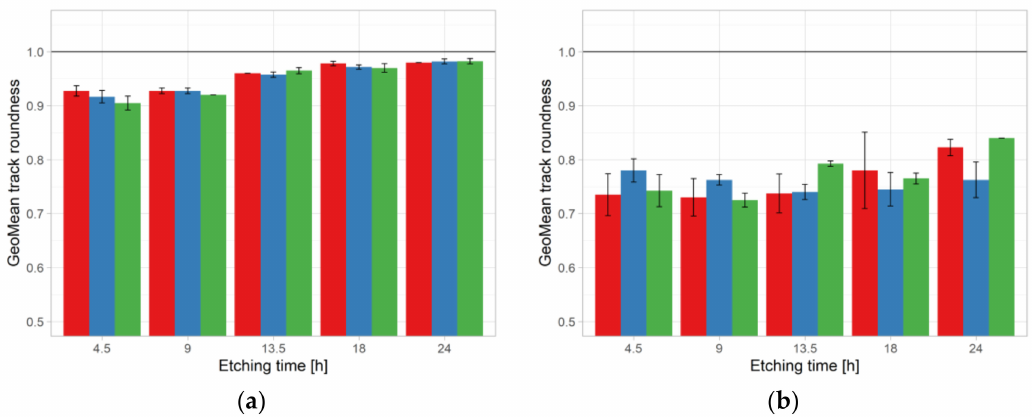
Figure 7. Roundness results obtained in Experiment 2 for 241 Am irradiation ( a ) and radon exposure ( b ). For color codes see Figures 3 and